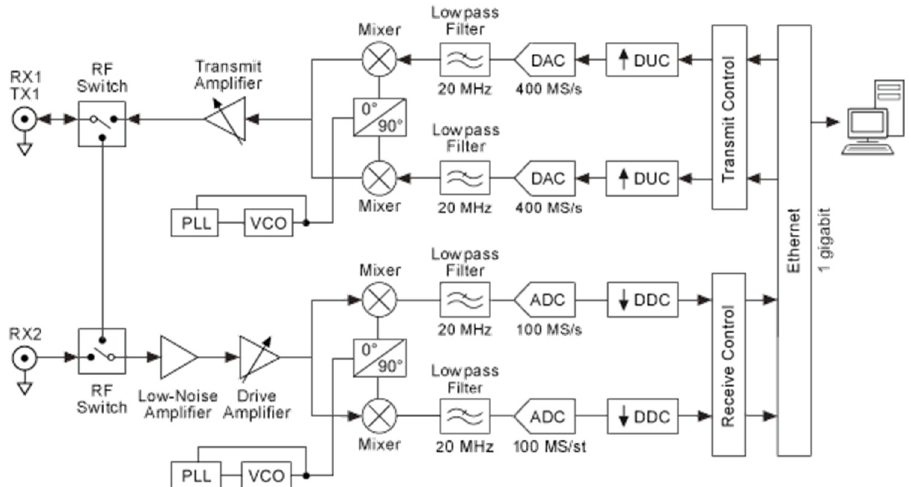
Figure 3. Block diagram of SDR platform. RX, Receiver; TX, Transmitter; VCO, Voltage-controlled oscillator; DAC, Digital-to-analog converter; DUC, Digital up converter; ADC, Analog-to-digital converter; DDC, Digital down converter.